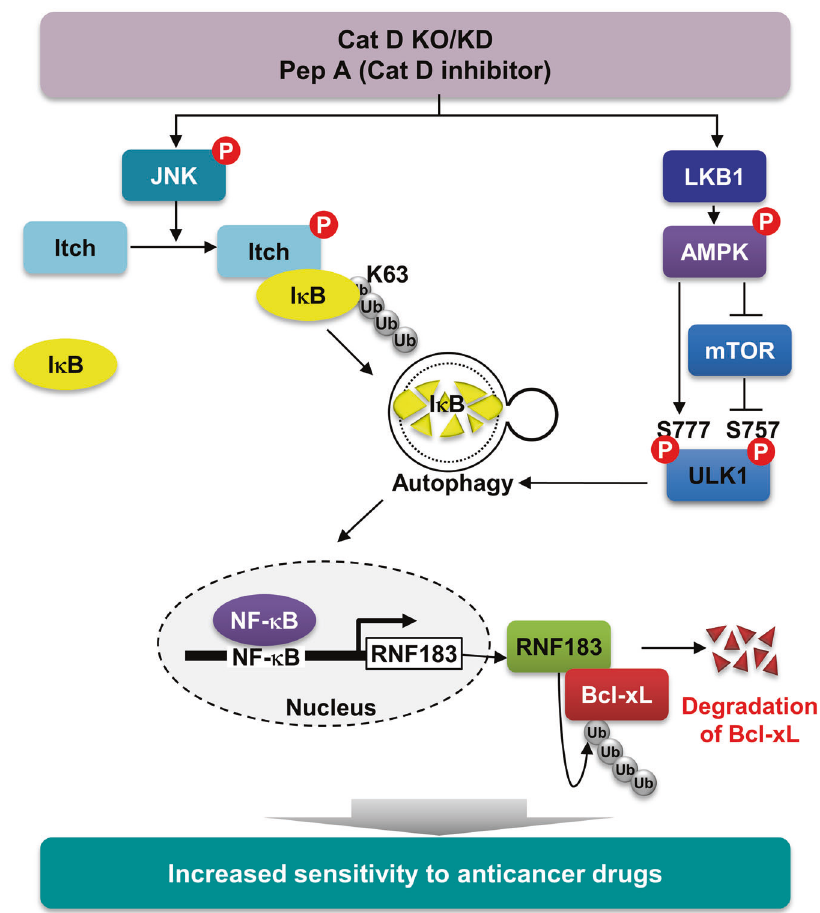
Fig. 8 Scheme indicating the mechanism of Cat D inhibition-induced sensitizing effect on anticancer drugs via activation of NF- κ B signaling. Two molecular mechanisms are associated with autophagy-mediated I κ B degradation by Cat D inhibition. First, depletion of Cat D phosphorylates Itch at T222 through activation of JNK signaling. Second, LKB1-mediated AMPK activation by Cat D inhibition phosphorylates ULK1 at S777, while ULK1 at S757 is dephosphorylated by inhibition of mTOR signaling. Subsequently, autophagy- dependent I κ B degradation is involved in Cat D inhibition-mediated sensitizing effect to anticancer drugs through RNF183-dependent Bcl-xL downregulation.